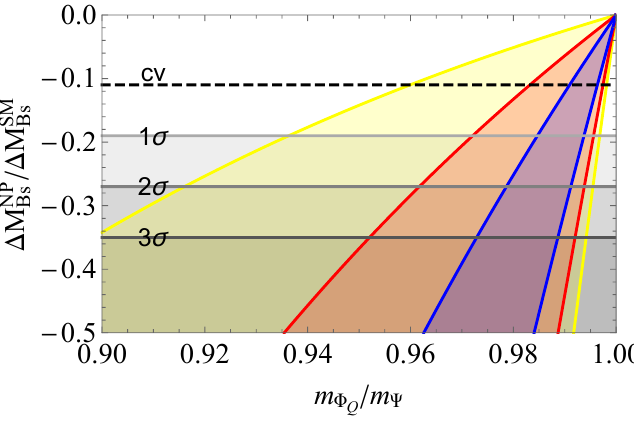
Figure 7 . Allowed regions in the m (cid:8) m (cid:8) = 2 m (cid:9) = 2 TeV and (cid:0) (cid:22) = 2. Blue, red and yellow corresponds to 1 (cid:27) , 2 (cid:27) and 3 (cid:27) , respectively. ‘ The regions below the gray lines are excluded by currant B s (cid:0) B s mixing data at the denoted (cid:27) level and the dotted line is the current central